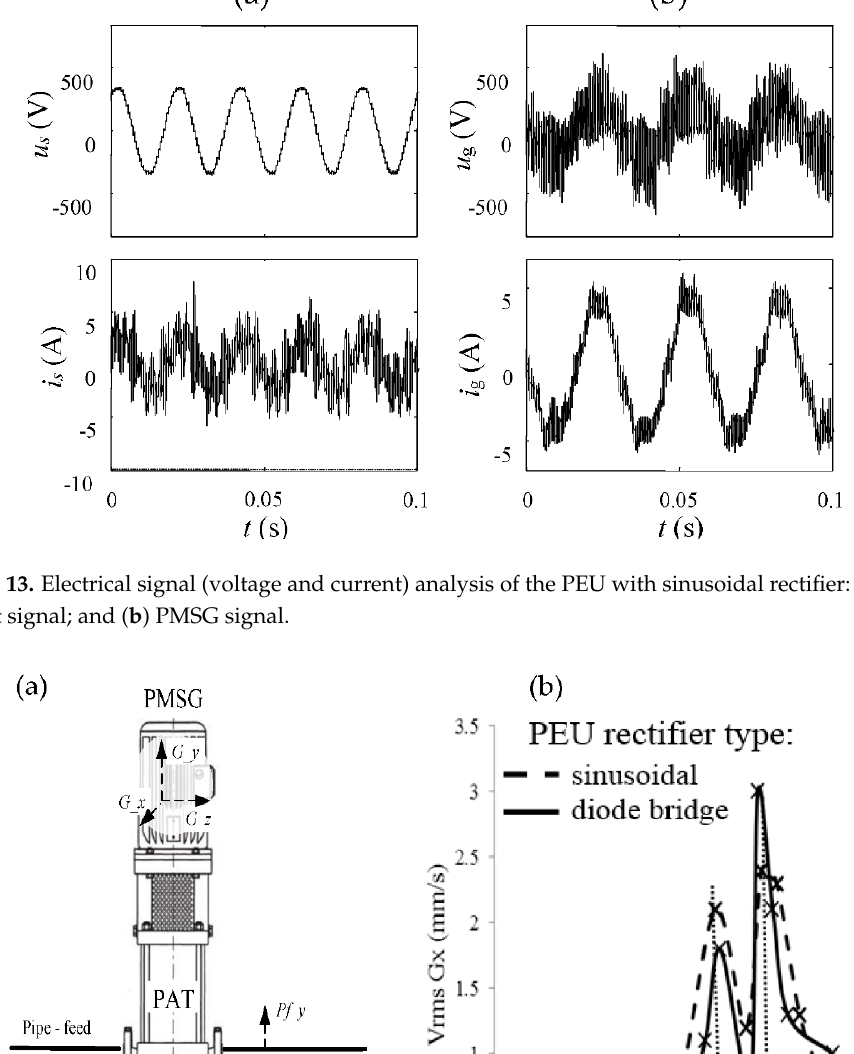
Figure 12. Electrical signal (voltage and current) analysis of the PEU with diode bridge rectifier: ( a ) PEU output signal; and ( b ) PMSG signal .